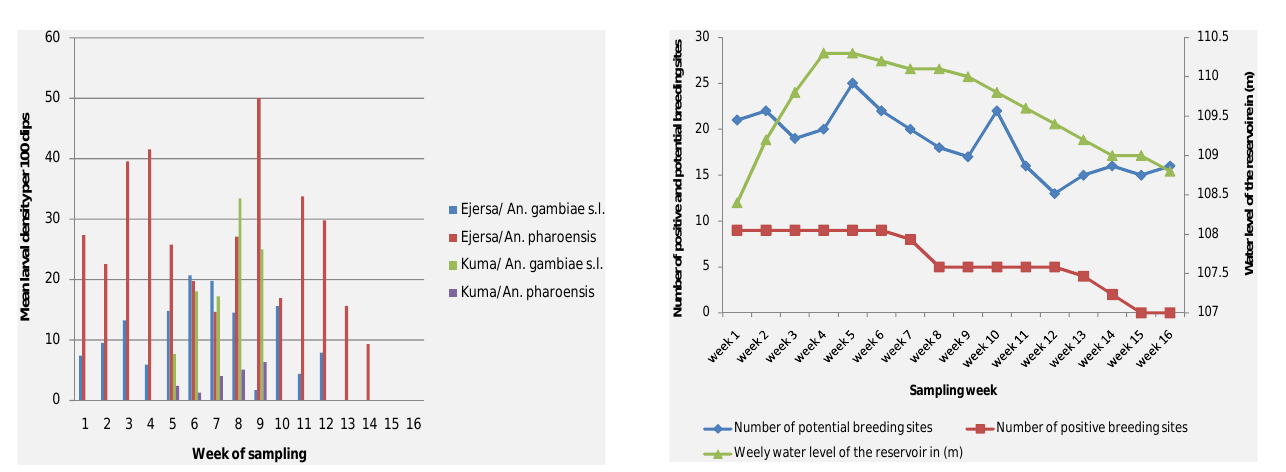
Fig. 4. Water Level (m) of the Koka reservoir, number of posi- Figure 4. Water Level (m) of the Koka reservoir, number of positive breeding sites, and number tive breeding sites, and number of potential breeding sites (August– of potential breeding sites (August -December 2007). December